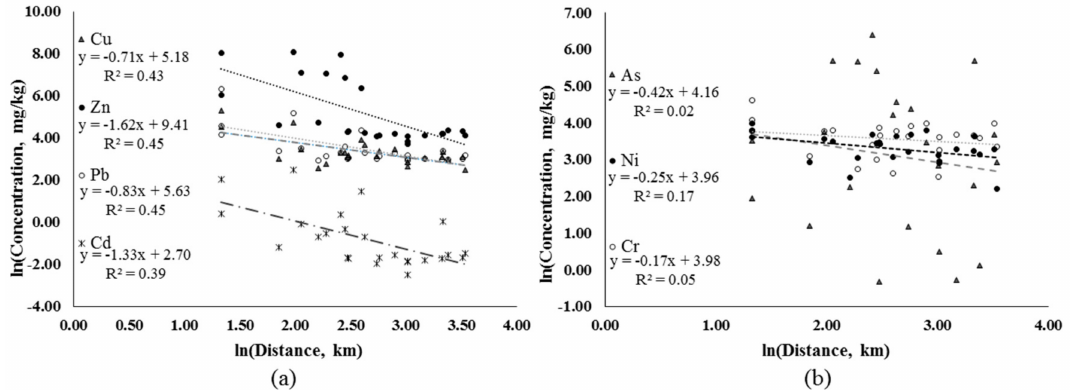
Figure 5. The relationship between element concentrations and distance to the mine: ( a ) Cu, Zn, Pb, and Cd, ( b ) As, Ni, and Cr.